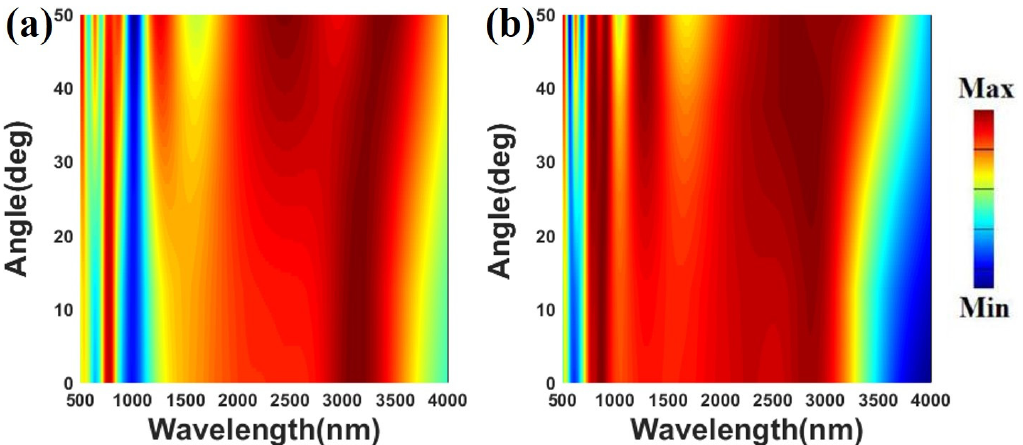
Figure 7. ( a ) Absorption spectra at different incident angles in TE mode. ( b ) Absorption spectra at different incident angles in TM mode.